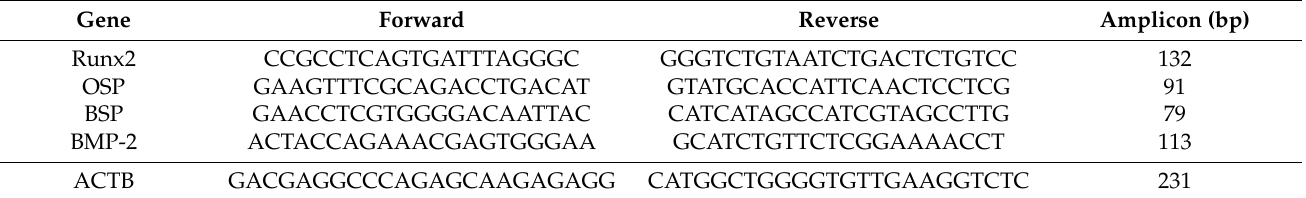
Table 2. Sequences of the primers for the human genes whose expression was assessed in qRT- PCR